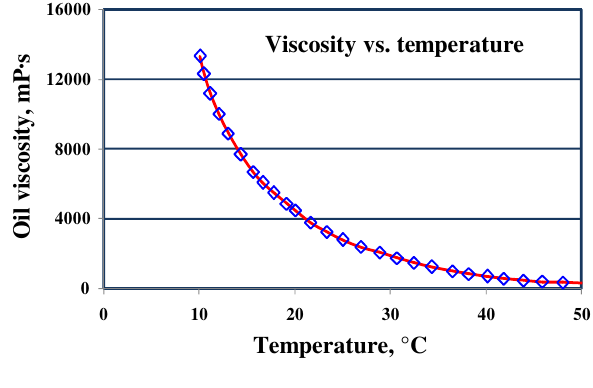
Fig. 1 Oil viscosity vs. temperature